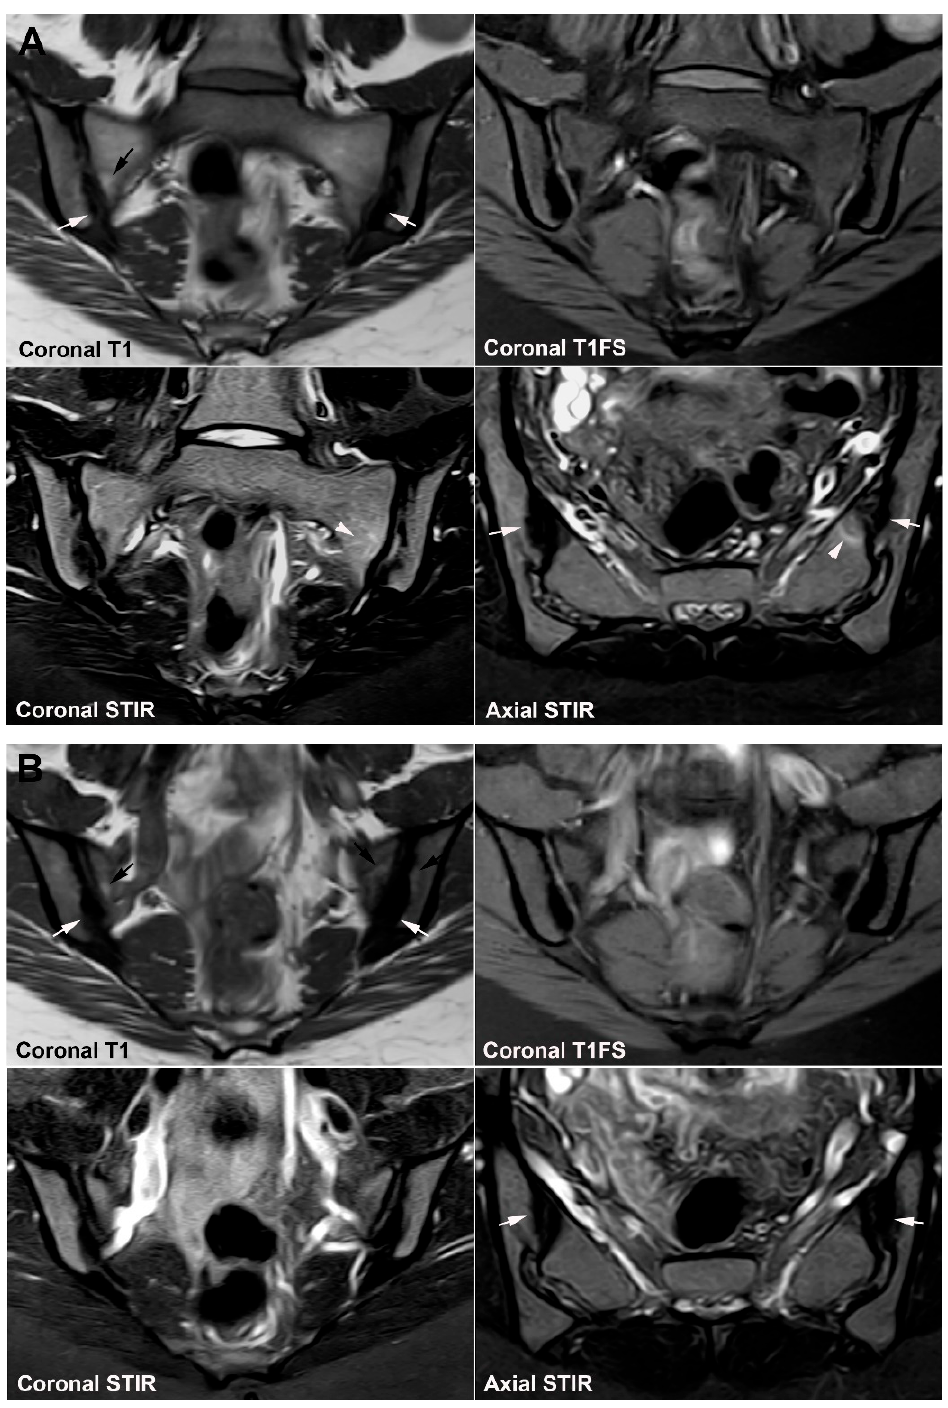
Figure 17. Evolution of postpartum MRI changes to OCI. MRI in a 26-year-old woman ( A ) 3 and ( B ) 12 months after her first normal vaginal delivery, semi-coronal T1, T1FS and STIR, and semi-axial STIR images at both time points. Iliac sclerosis was present at both time points (white arrows) but became more homogeneous and signal void during the 9-month period. At 3 months postpartum there was concomitant BME at the anterior middle part of the sacrum on the left side (arrowheads) which vanished 12 months postpartum. Small areas with fat deposition (black arrows on T1) either located in the subchondral bone or peripheral to the iliac sclerosis were seen at both-time points, but no erosions.